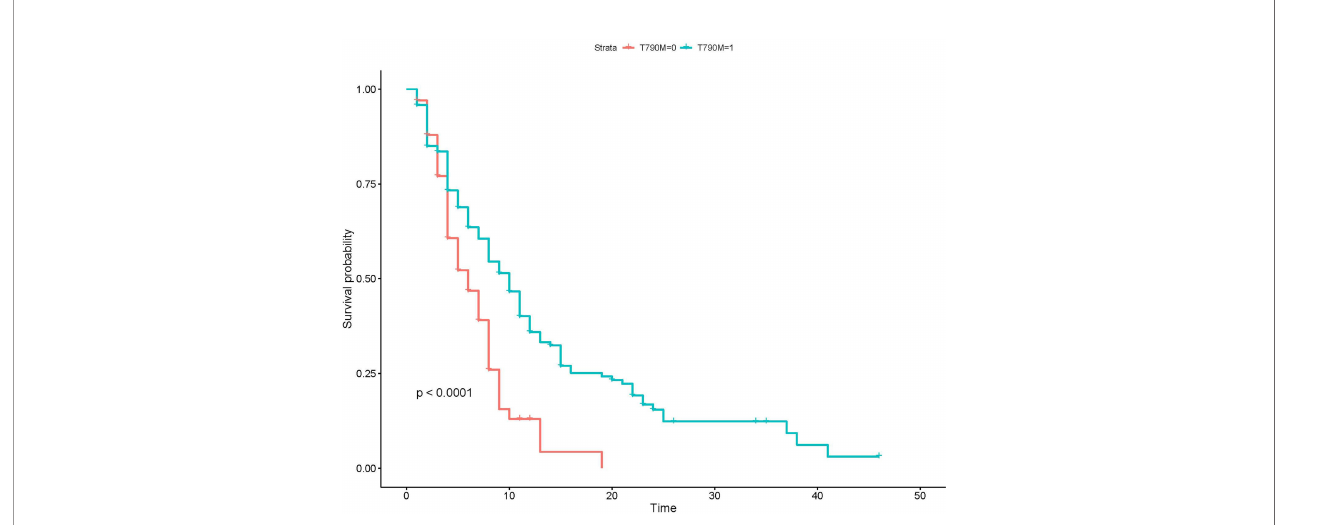
FIGURE 3 | Kaplan – Meier analysis of patients with different T790M mutation status. T790M-0, the group without acquired T790M mutation; T790M-1, the group with acquired T790M